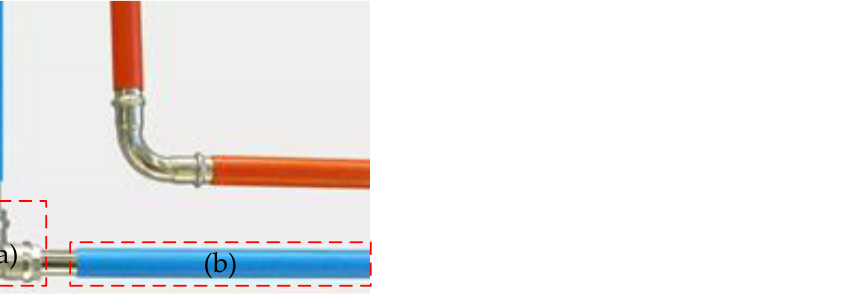
Figure 3. An instance of MEP elements: ( a ) a changed normal vector; ( b ) an unchanged normal